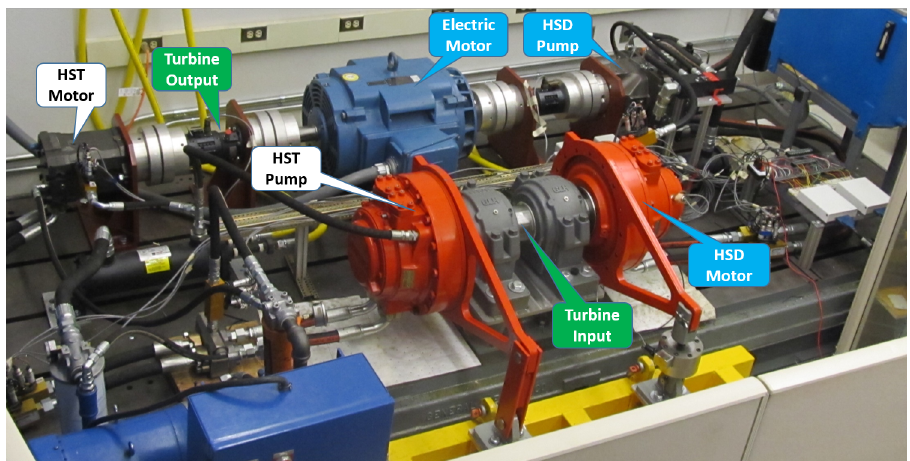
Figure 2. A 100 kW power regenerative hydrostatic